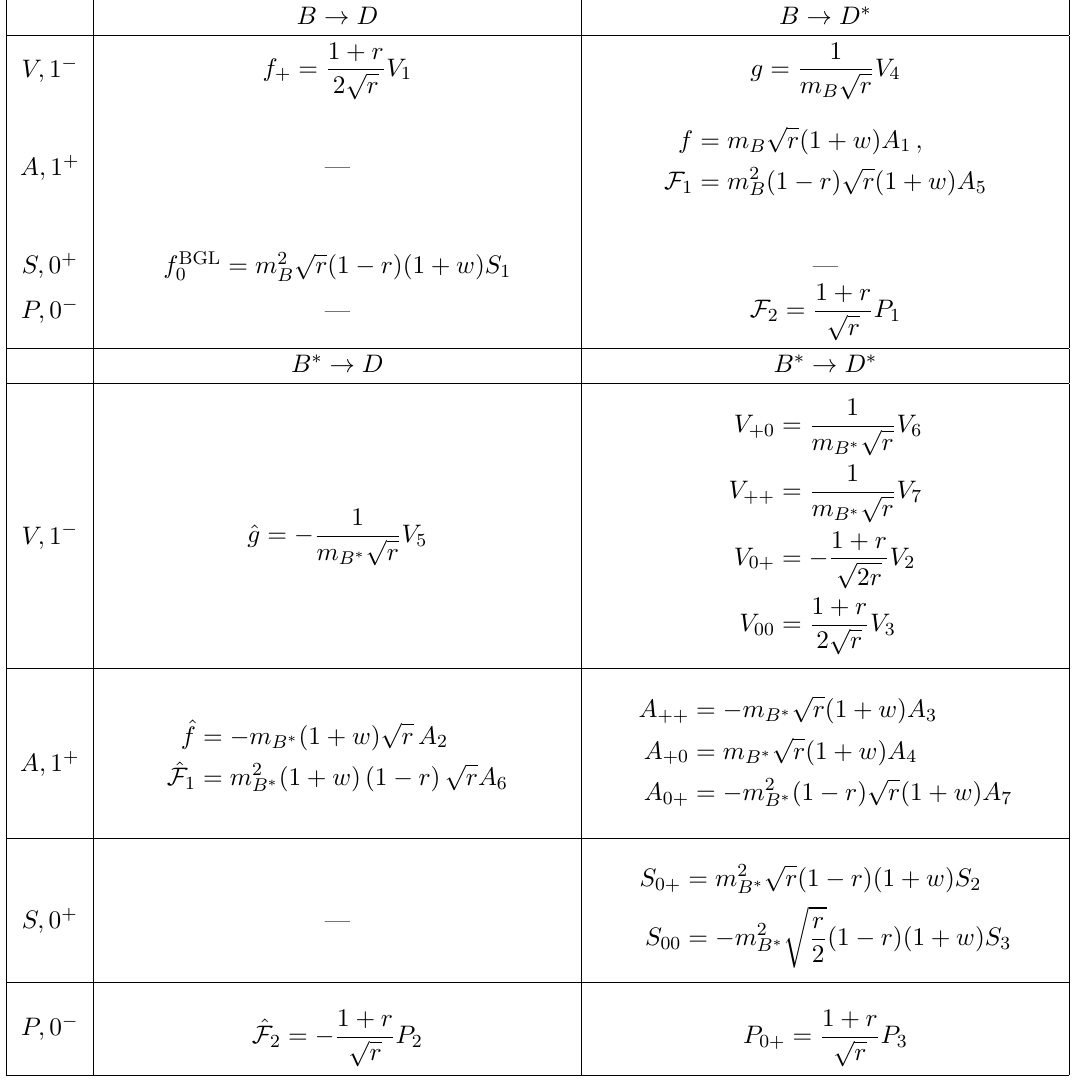
Table 1 . Relations between form factors in the BGL (left) and CLN (right) notation. r is the